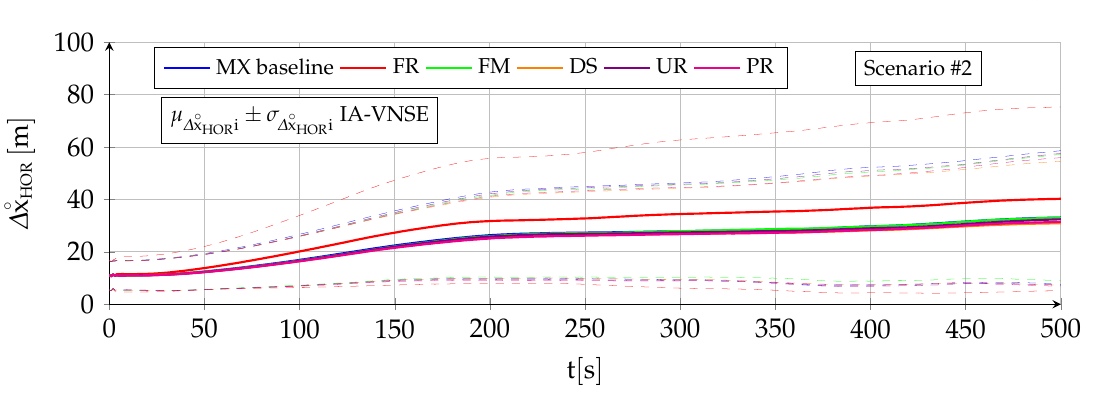
Figure 19. Influence of terrain type on horizontal position IA-VNSE for scenario #2 (100 runs).